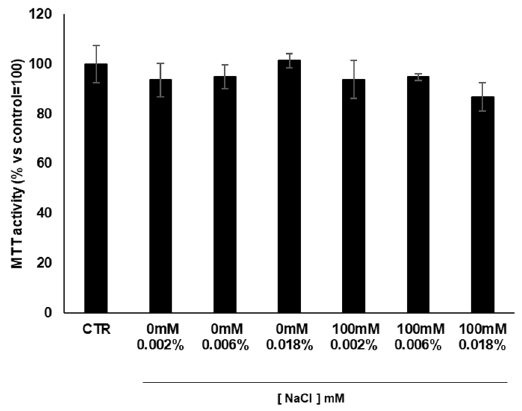
Figure 5. Protection activity of cardoon calli extracts on cell viability. Human keratinocytes were treated with the test compounds at different concentrations. The cells were processed as described in the Material and Methods section to measure cell viability (MTT assay). Each value represents the mean of three biological replicates ± SD. CTR, control unstressed cells; 0 mM and 100 mM NaCl, saline stress treatments.